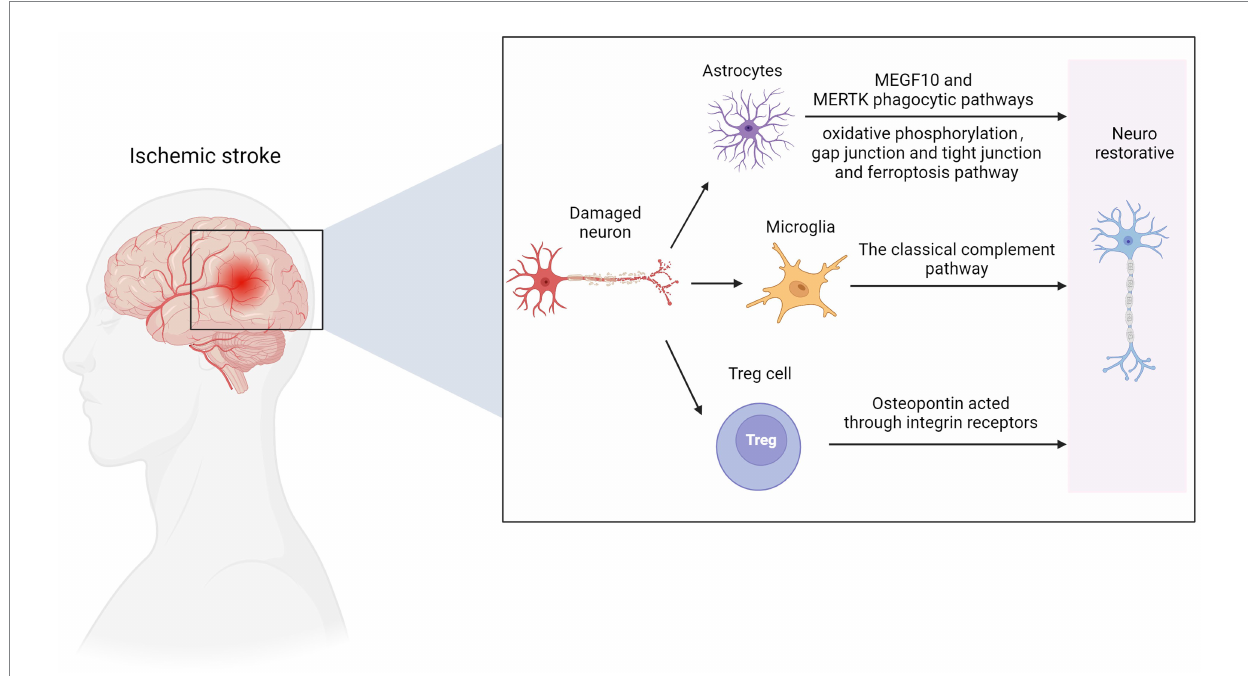
FIGURE 3 Nerve repair in ischemic stroke. MEGF10, multiple EGF like domains 10; MERTK, MER proto-oncogene, tyrosine kinase. Figure was created with